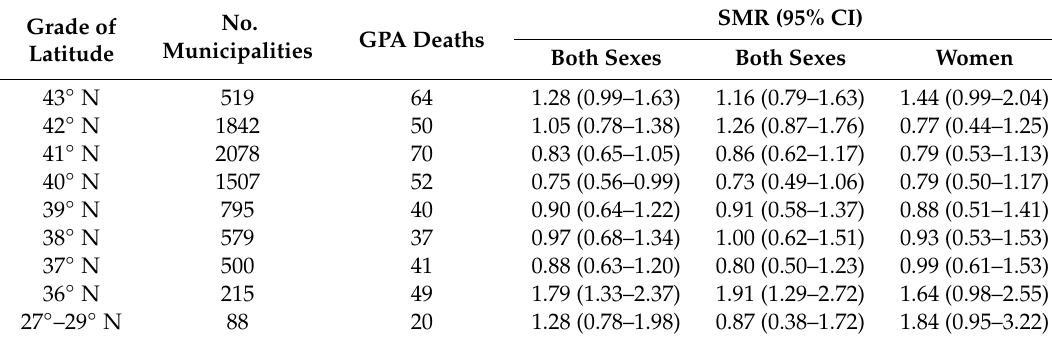
Table 2. Number of municipalities, deaths and standardized mortality ratio (SMR) results for each degree of latitude due to GPA disease over the period 1999–2016 in Spain.